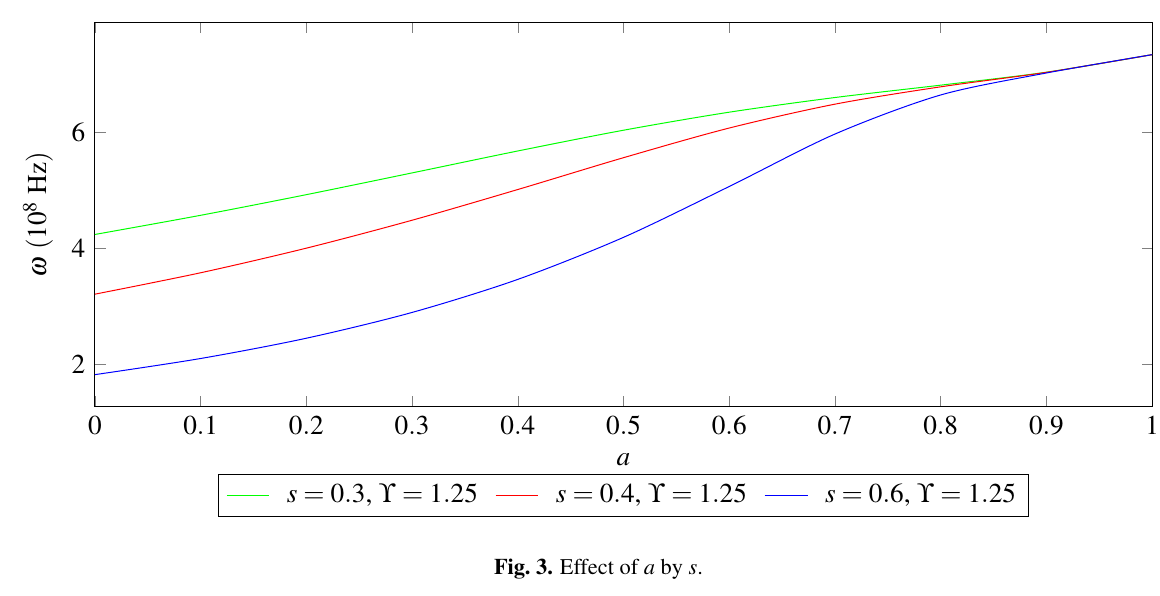
Fig. 3. Effect of a by s .